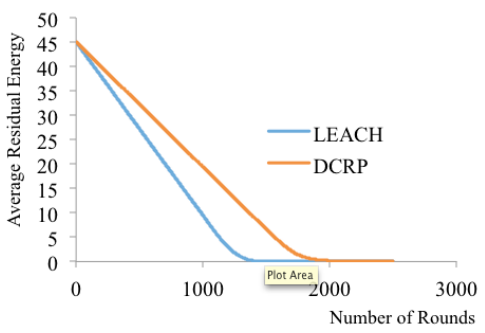
Fig. 8. Average Residual Energy versus rounds